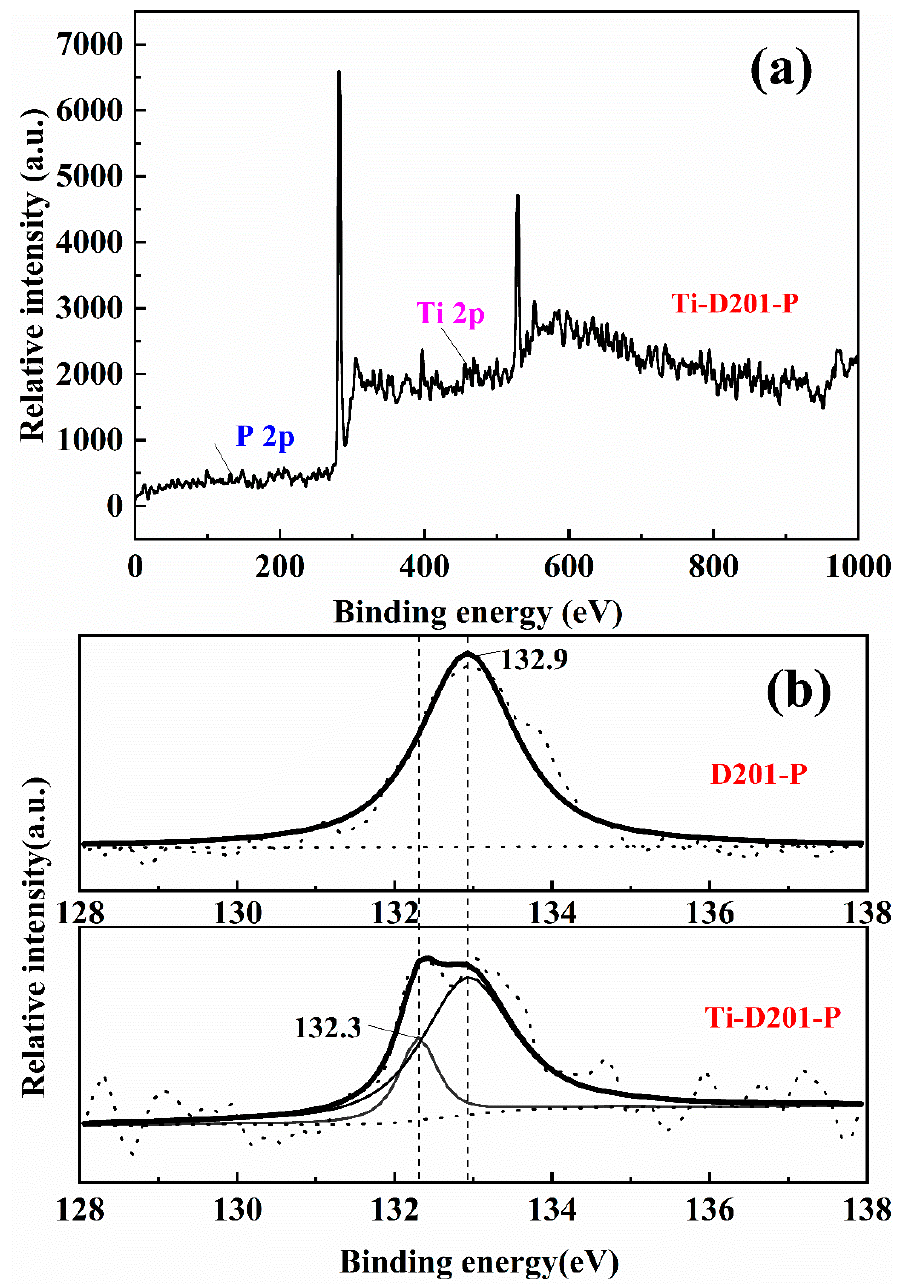
Figure 9. ( a ) Wide scan XPS spectra of phosphate loaded HTO-D201. ( b ) P2p XPS spectra of phosphate loaded D201 and HTO -D201.